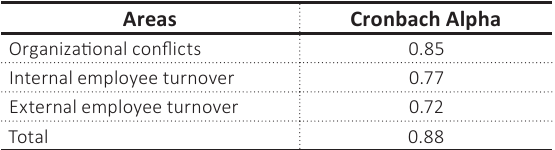
Table 2. Cronbach-Alpha